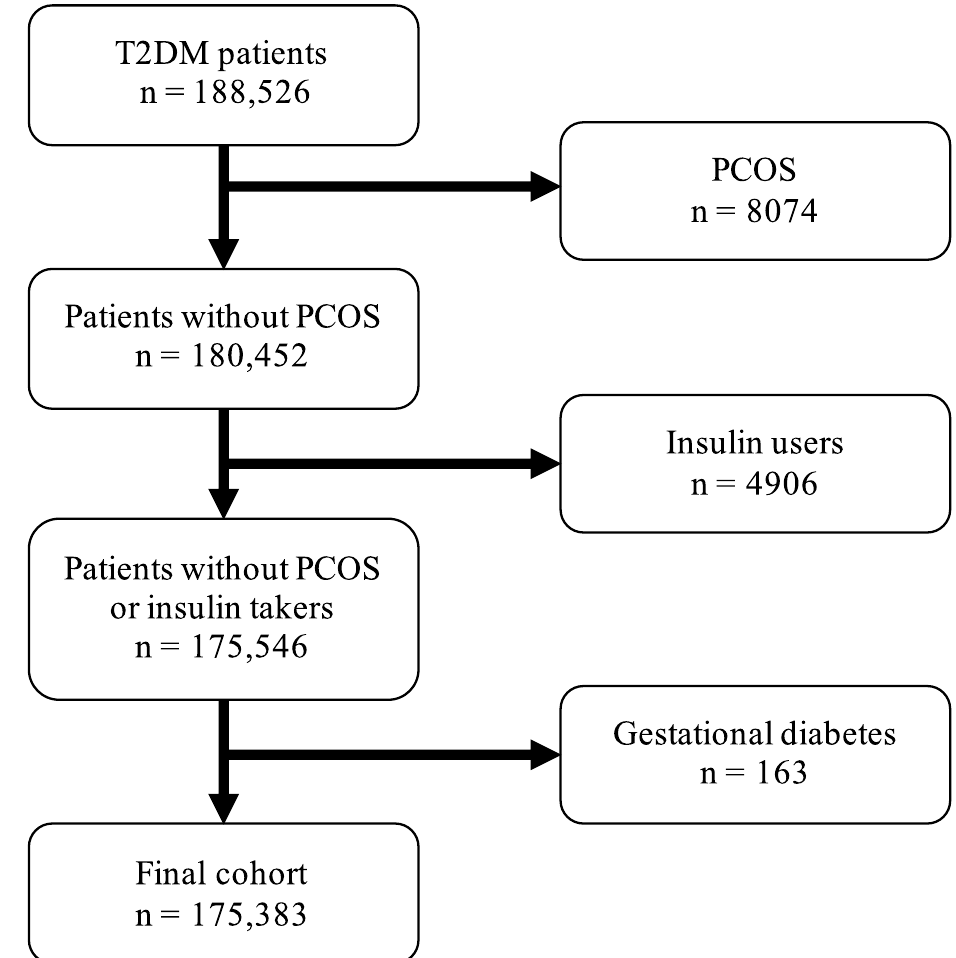
Figure 1. Flowchart of included patients. T2DM type 2 diabetes mellitus, PCOS polycystic ovarian